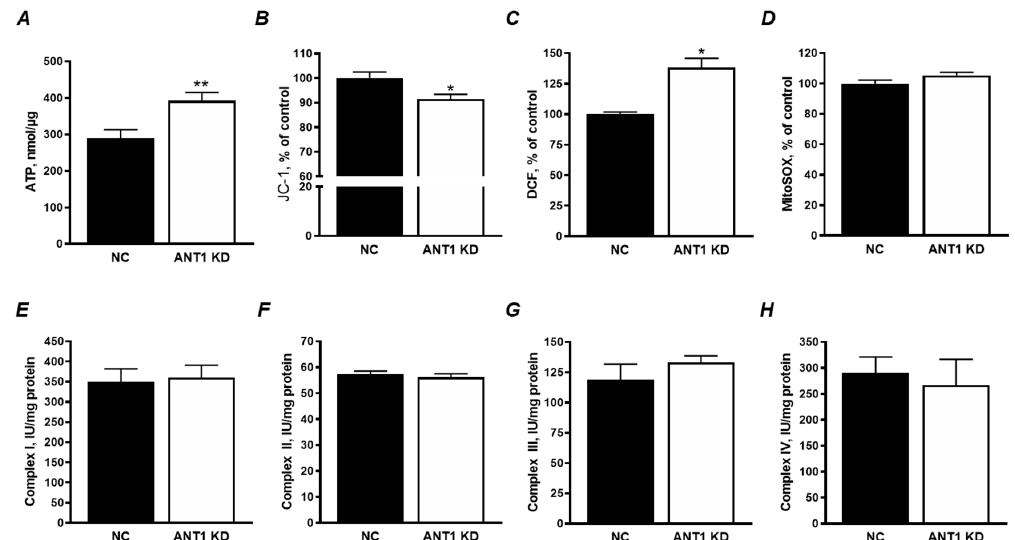
Figure 2. ANT1 KD disturbs mitochondrial membrane potential ( ΔΨ m) without affecting enzymatic activity of ETC complexes. ( A ) Total cellular ATP levels normalized to the total amount of protein. ( B ) Mitochondrial membrane potential determined with JC-1 after transfection and calculated as the ratio of J-aggregates to JC-1 monomers. ( C ) Total cellular ROS assessed with H 2 DCFDA; ( D ) MtROS assessed using MitoSOX red. Data on the fluorescence activity in the cells ( B – D ) are presented as percent change of negative control (NC). ( E – H ) The enzymatic activity of complexes I, II, III and IV in mitochondria isolated from NC and ANT1 KD cells. Data were normalized to mitochondrial protein levels. * P < 0.05, and ** P < 0.01 vs. control (NC). Data represent 3 independent experiments.